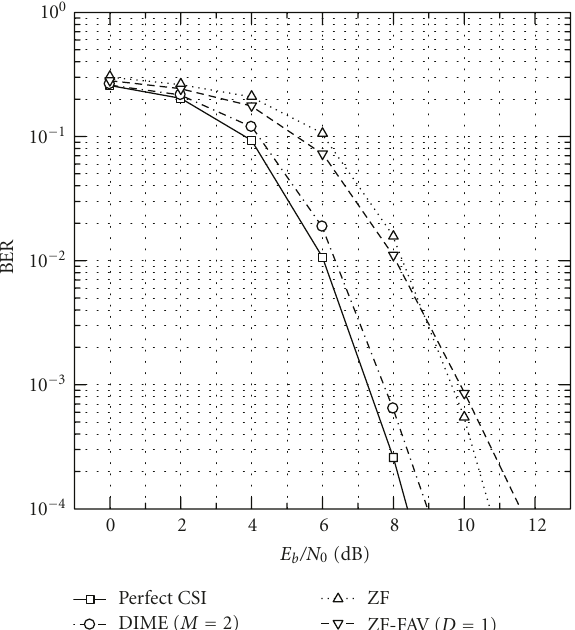
Figure 5: NMSE performance with σ/T = 0 . 123 and f d T = 0.0075.